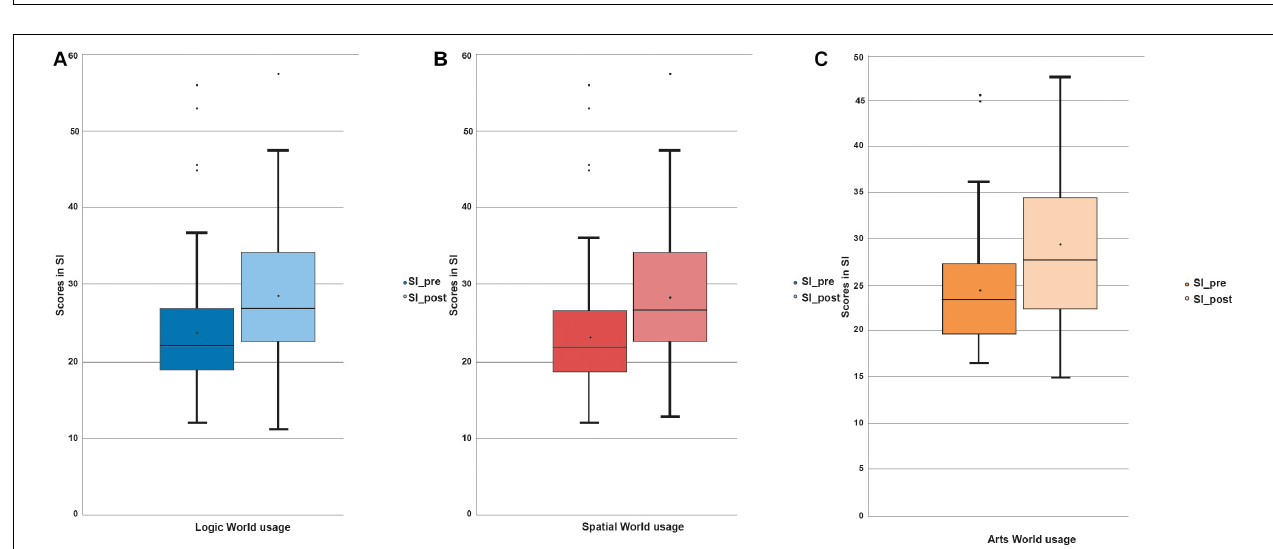
FIGURE 4 | (A) Graphic of S1 Scores from students that played the Logic World. (B) Graphic of S1 Scores from students that played the Spatial World. (C) Graphic of S1 Scores from students that played the Arts World.